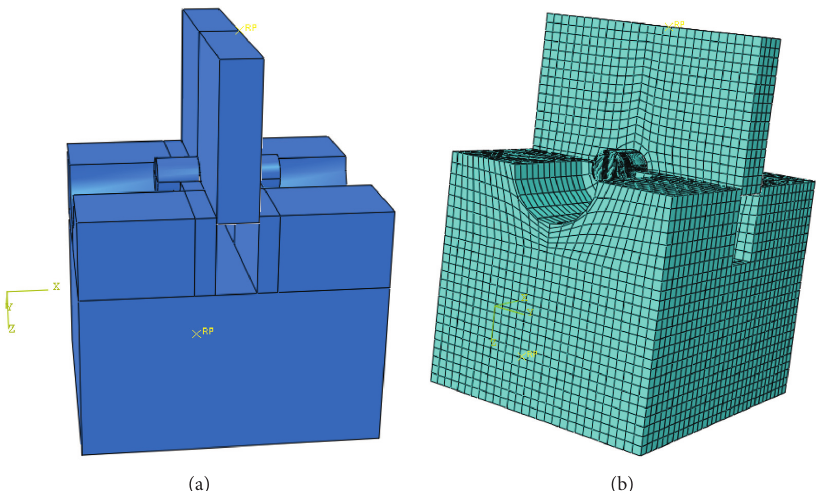
Figure 13: Geometry and simulation model of material shear test. (a) Material test sample and fixture geometry. (b) Material test sample and fixture FE model.